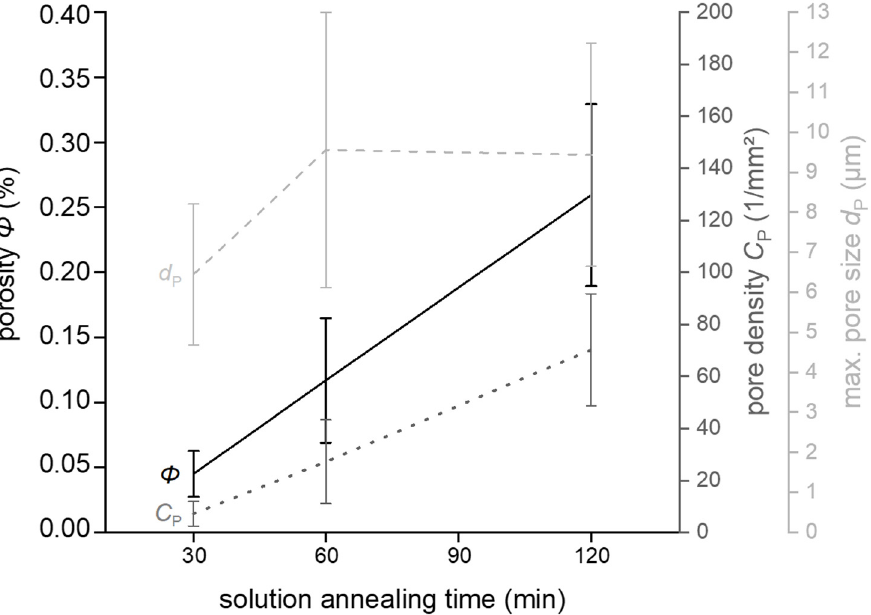
Figure 9. Results of quantitative microstructural analysis of porosity, pore density and maximum pore size. An increase in the solution annealing time resulted in increases in porosity, pore density and size.